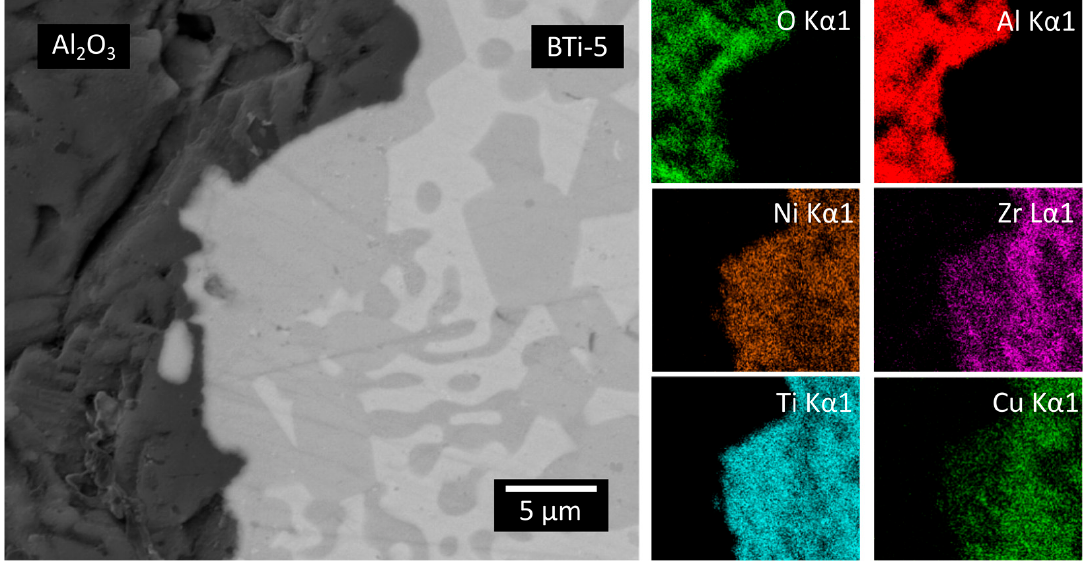
Figure 11. FE-SEM BSE image of the interface of Al 2 O 3 and the filler metal in the circular joining configuration. EDS maps of the main elements of the two materials.